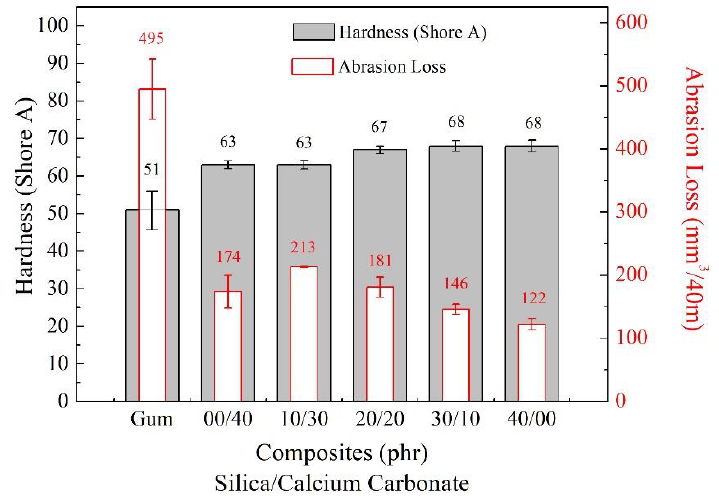
Figure 10. Shore A hardness of gum and the hybrid composites with silica (SiO 2 + Si69 ® ) and calcium carbonate (CaCO 3 ) treated with 2% Chartwell ® measured with a Kiltler durometer. The volume loss by abrasion was measured using a rotating drum, 150 mm in diameter, at a frequency of 40 rpm and a nominal distance of 40 m.